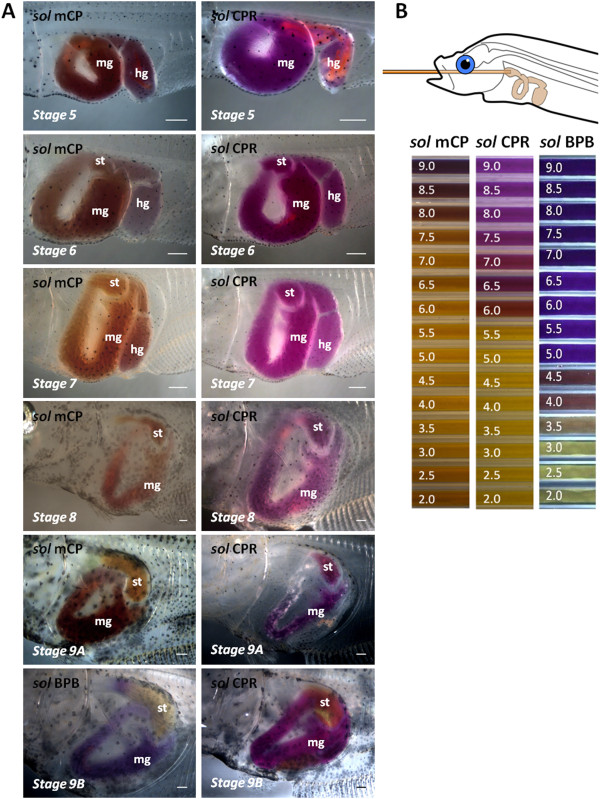
pH changes in the GI-tract of Atlantic halibut larvae during development. Panel A: results of tube feeding pH indicator solutions into larva from premetamorphosis (stage 5) to climax metamorphosis (stage 9A and 9B). pH sol mCP contained 0.1% M-Cresol purple, sol CPR consisted of 0.1% Chlorphenol Red and pH sol BPB had 1% of Bromophenol blue. st: stomach/presumptive stomach; mg: midgut; hg: hindgut. Scale bar = 0.5 mm. Panel B: standards immersed in water and photographed with similar light condition as larvae under the dissecting microscope.